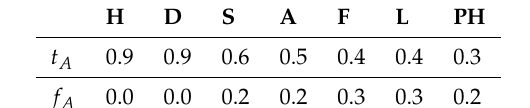
Table 5. Power based on membership and non-membership degrees.